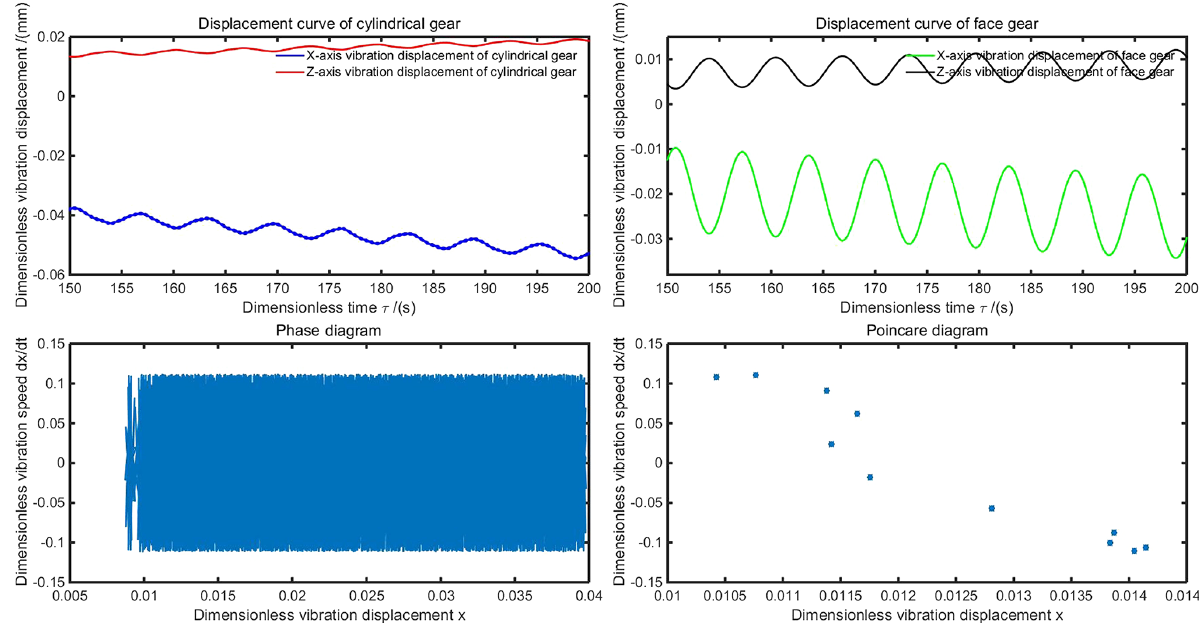
Figure 13. Displacement, phase and Poincare diagrams of linear system with excitation frequency 0.1648Hz.